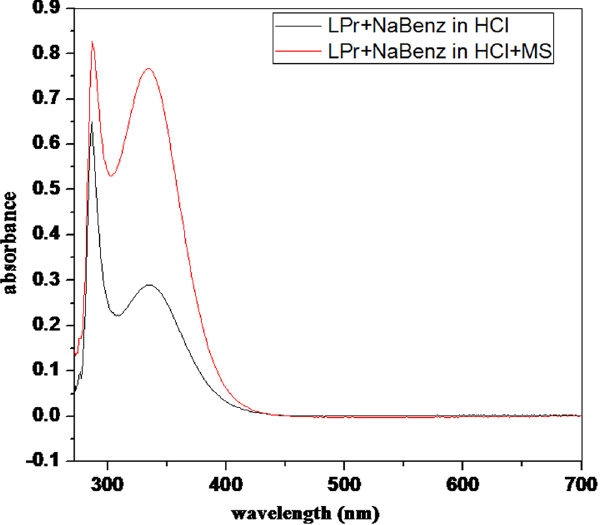
Figure 12. UV-vis spectra of acidic solutions of 500 ppm LPr + 10 ppm NaBenz before and after 6 h immersion of mild steel.